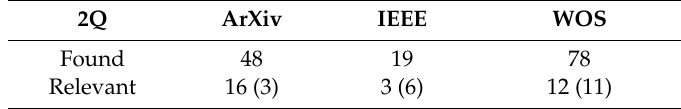
Table 2. Results from the search after “Challenges image caption generation” search query.